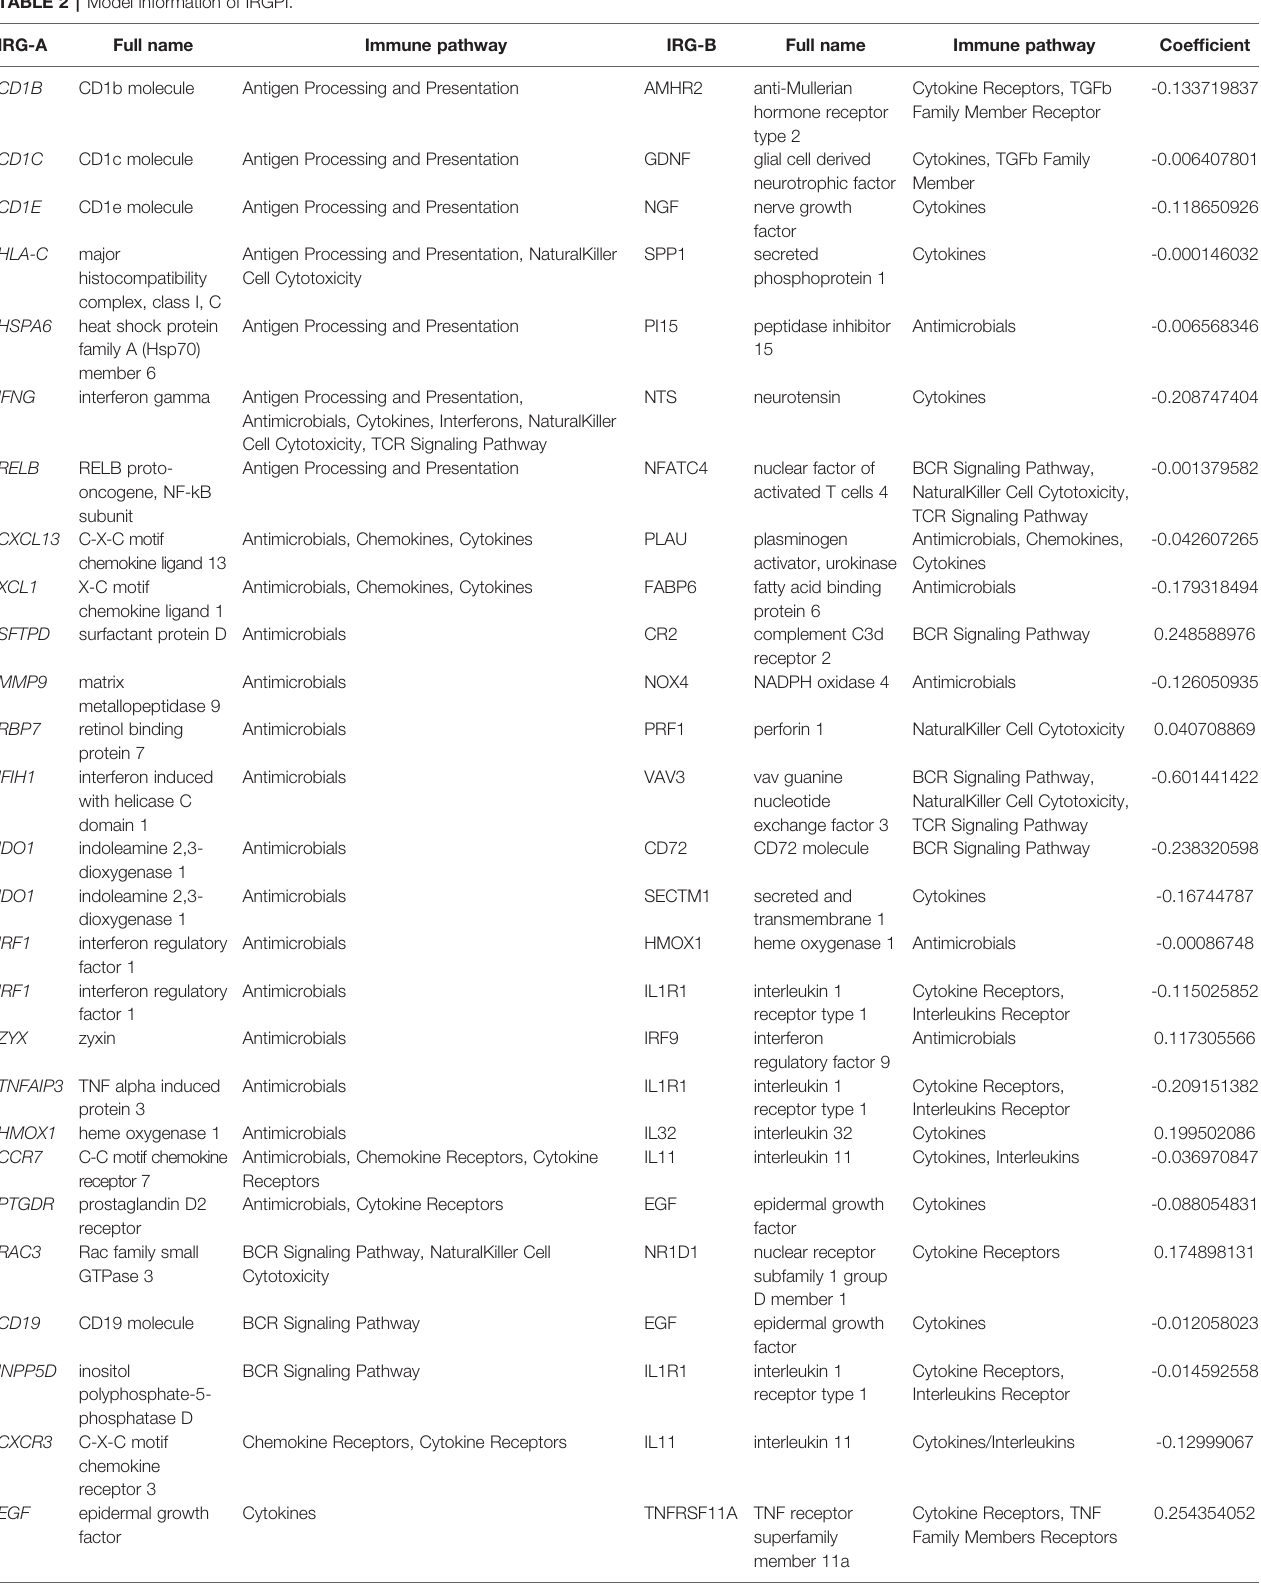
TABLE 2 | Model information of